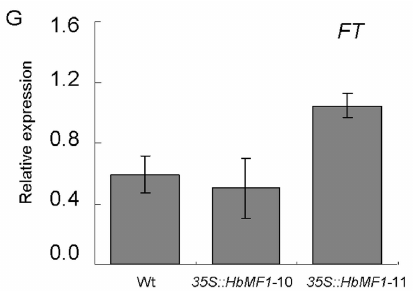
Figure 9. Effect of over-expressing HbMFT1 on flowering. ( A ) Flowering phenotypes of wt and 35S:: HbMFT1 transgenic lines; ( B ) Comparison of flowering time and number of cauline and rosette leaves at flowering between wt and 35S:: HbMFT1 transgenic lines; ( C – G ) Expression analysis of genes related with flowering in wt and 35S:: HbMFT1 transgenic lines. Total RNA was isolated from seedlings growing at 25 days after germination, which was the transition phase of Arabidopsis bolting. Values were means ˘ SE from three independent biological replicates. The levels of significance: ** refers to p < 0.01. Abbreviations: SOC1 , SUPPRESSOR OF OVEREXPRESSION OF CONSTANS 1 ; LFY , LEAFY ; FUL , FRUITFULL ; AP1 , APETALA1 ; FT , FLOWERING LOCUS T